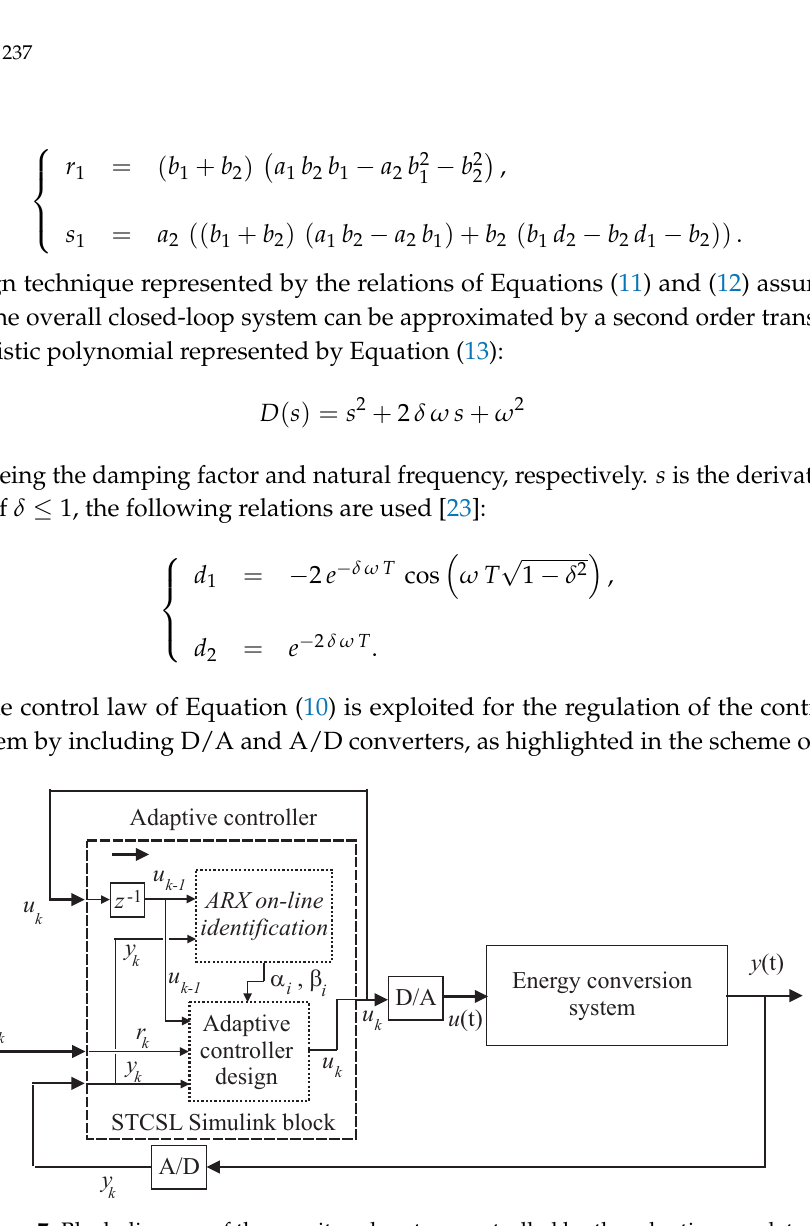
Figure 7. Block diagram of the monitored system controlled by the adaptive